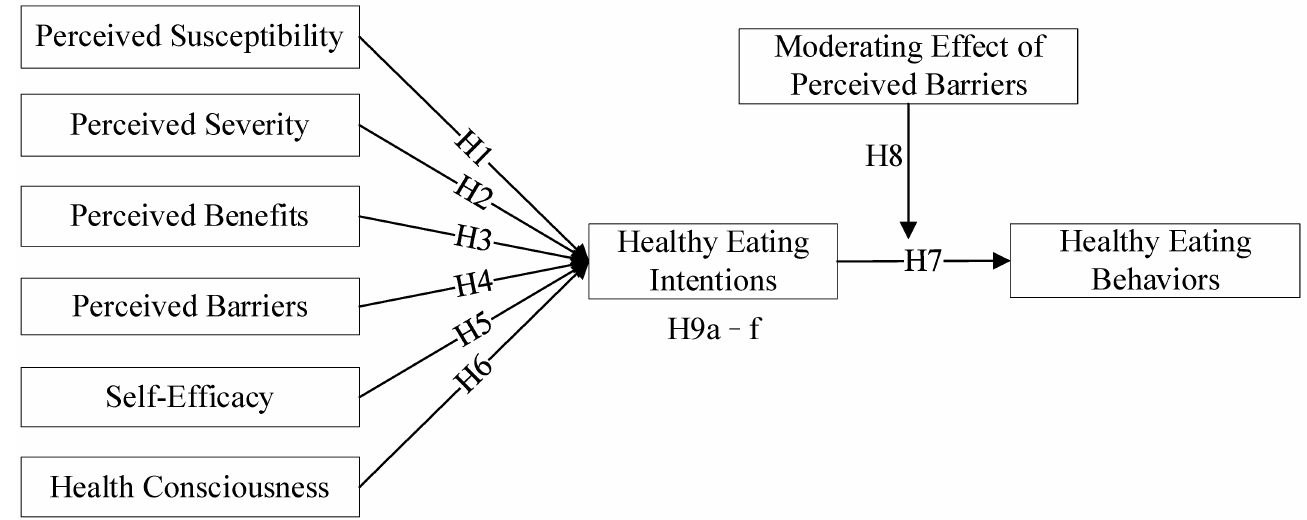
Figure 1. Theoretical hypothesis